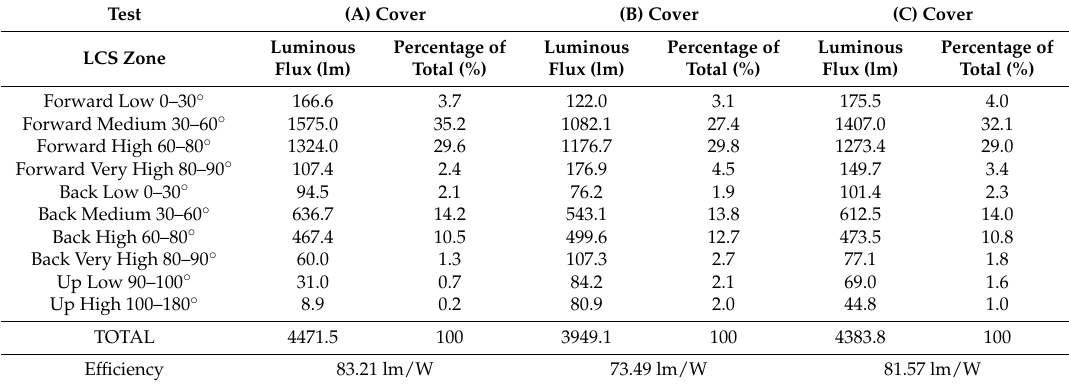
Table 4. Luminaire Classification System (LCS) of the covers under study. Criteria: IESNA TM-15-07.